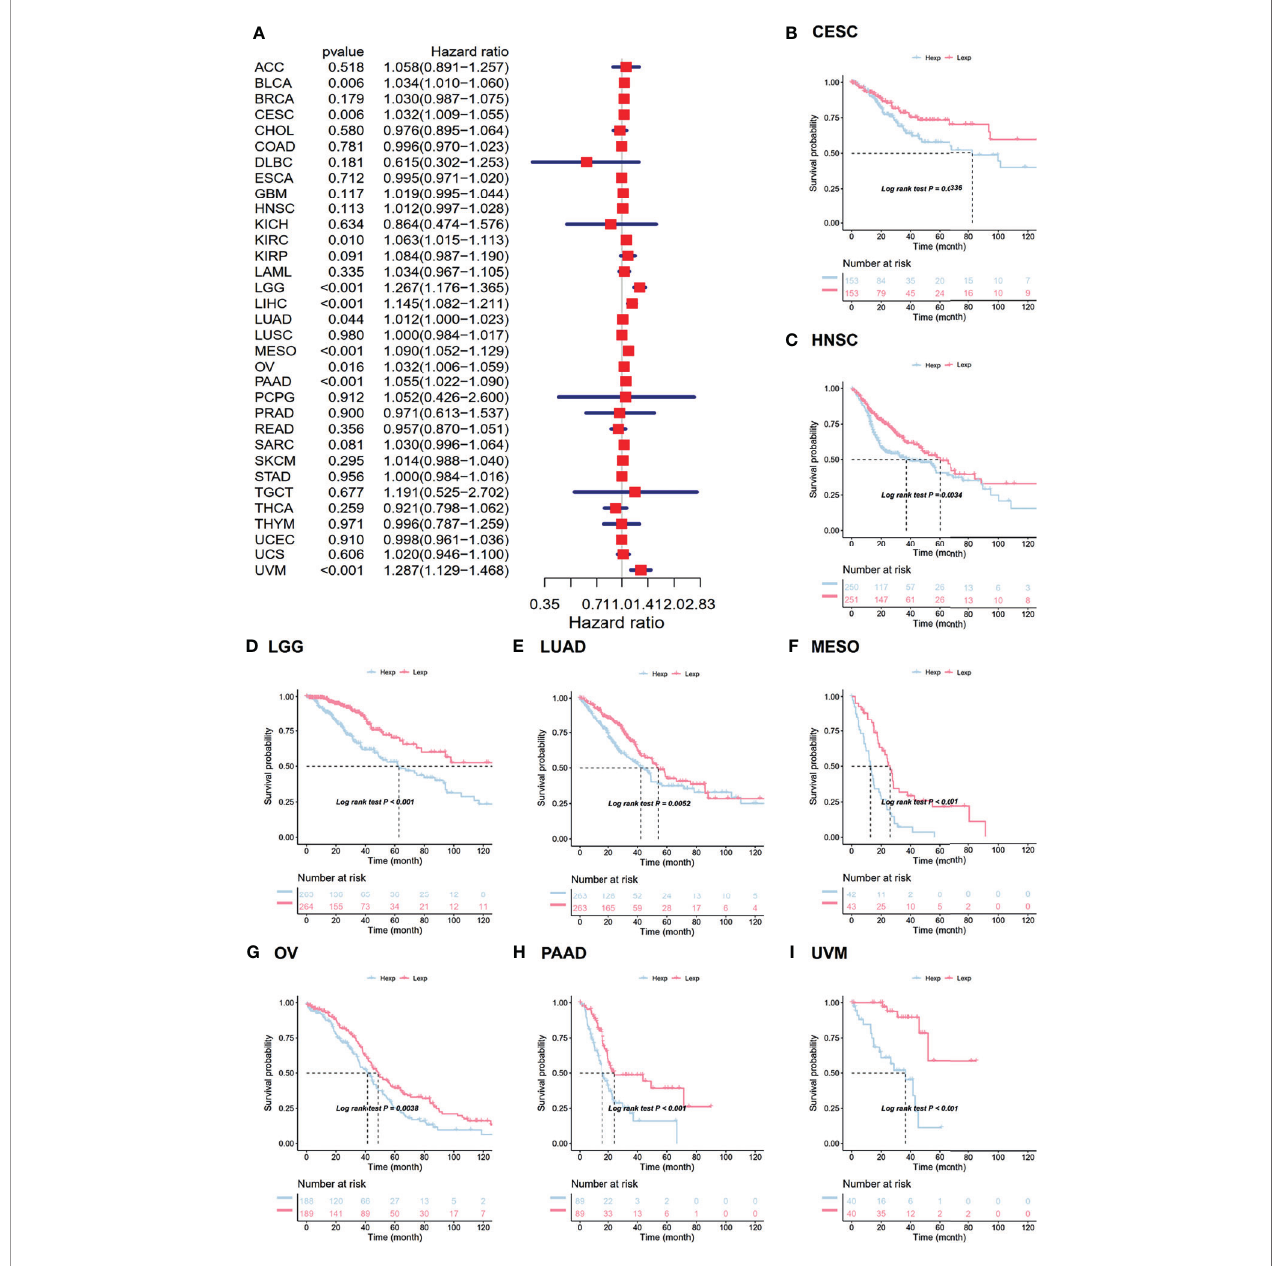
FIGURE 2 | Relevance for ANXA2P2 expression levels to overall survival in months. (A) Forest map related to OS of pan-carcinoma. Kaplan-Meier analysis of the correlation between ANXA2P2 expression and OS in (B) CESC, (C) HNSC, (D) LGG, (E) LUAD, (F) MESO, (G) OV, (H) PAAD, and (I)